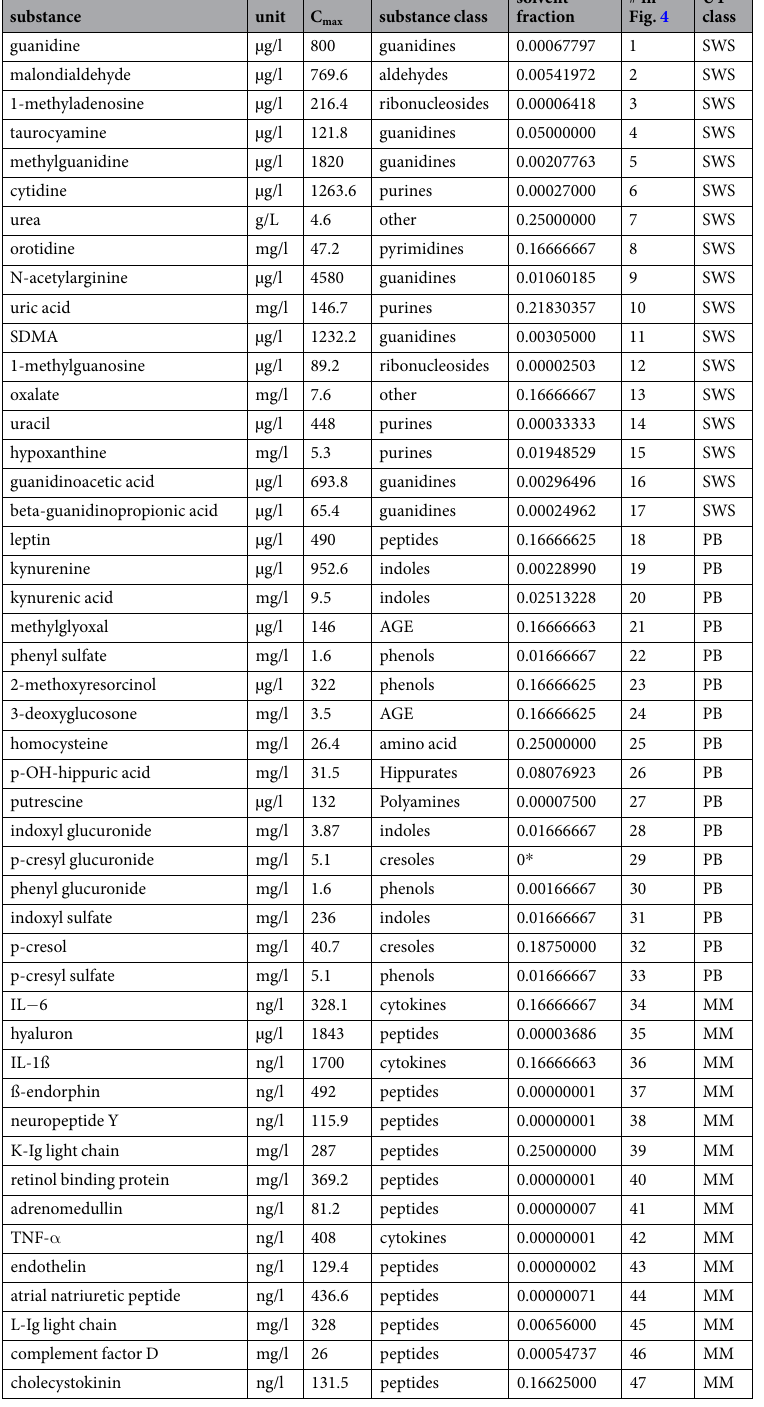
Table 1. List of uremic toxins tested. C max indicates applied concentration. NaCl or H 2 O were used as solvents. Solvent fraction defines remaining volume (V) of solvent in-vitro (by the ratio: V solvent /V total ). PBS was used to dilute. UT = uremic toxins. SWS = small water-soluble compounds, PB = protein bound, MM = middle molecules. AGE = advanced glycation end products. * Directly solved by